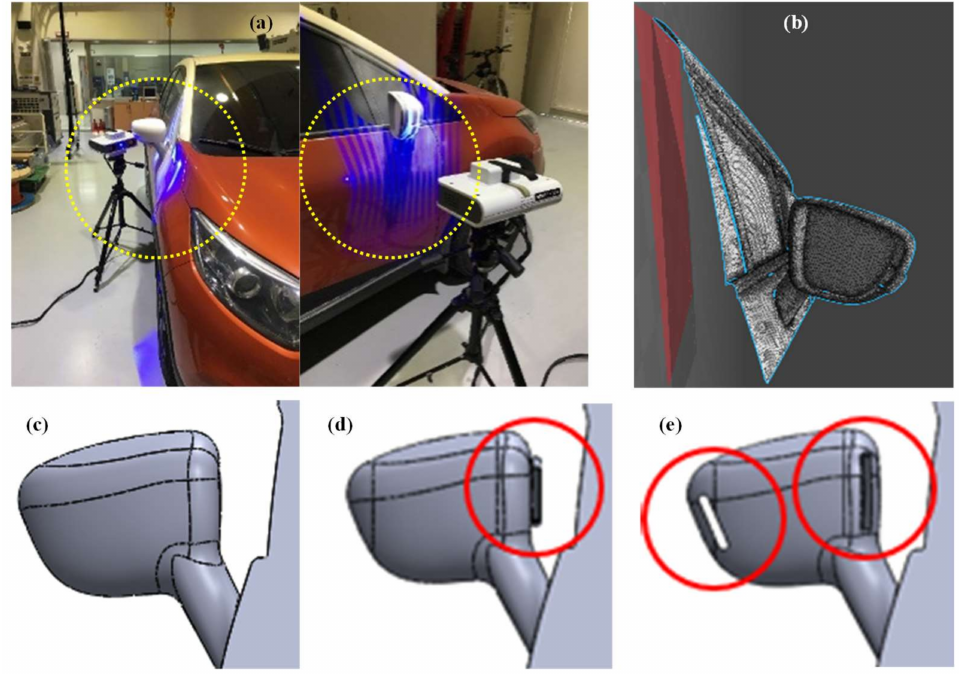
Figure 1. Three-dimensional (3D) scanning process to gather a 3D computer-aided design (CAD) model and three types of OSRVM models: ( a ) 3D scanning apparatus; ( b ) Extraction of the mirror shape from the scanned data; ( c ) Reference model; ( d ) Outer duct model; ( e ) Inner duct